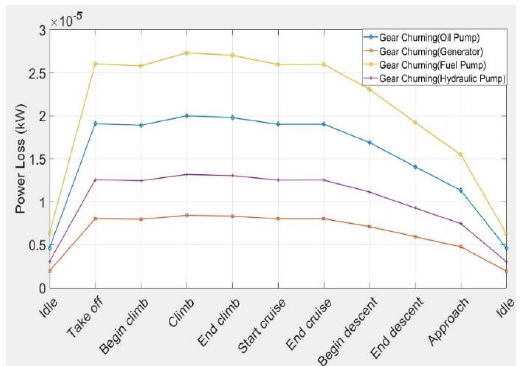
Figure 5. Power losses due to gear churning. Int. J. Turbomach. Propuls. Power 2020 , 5 , x FOR PEER REVIEW